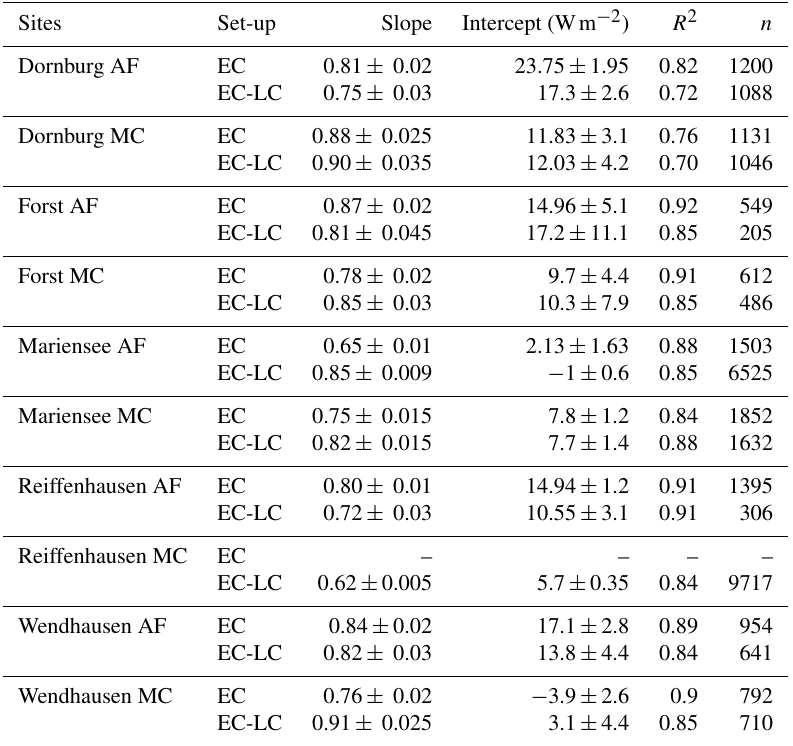
Table 5. Statistical analysis results of the linear regression between the sum of the turbulent fluxes and the available energy, namely the sites, the set-up used, the slope ( ± 5% confidence interval), the intercept, the coefficient of determination of the linear regression ( R 2 ), and the number of points used for the analysis ( n ). The energy balance closure determined by EC-LC at Mariensee AF is based on data collected from 23 March to 20 November 2016, and at Reiffenhausen MC, the analyses are based on data collected from 7 April to 31 December 2016 due to the unavailability of data during the campaigns. The energy balance closure determined by EC for Reiffenhausen MC is missing due to the unavailability of a